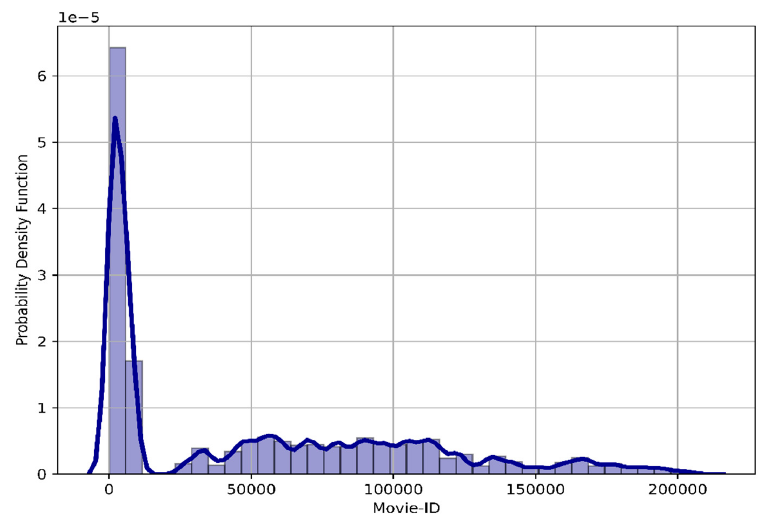
Figure 5. Probability density function (PDF) of the Movie-ID on the basis of movie request.